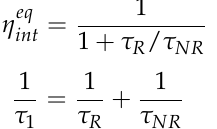
Figure 2. ( a ) Statistics of PL intensity of Micro-LEDs treated by different parameters; ( b ) PL spectra of Micro-LEDs sample S1 to S5; ( c ) TDPL spectra and IQE of untreated sample S1; ( d ) TDPL spectra and IQE of optimized-treated sample S5; ( e ) TRPL of sample S1 and sample S5.